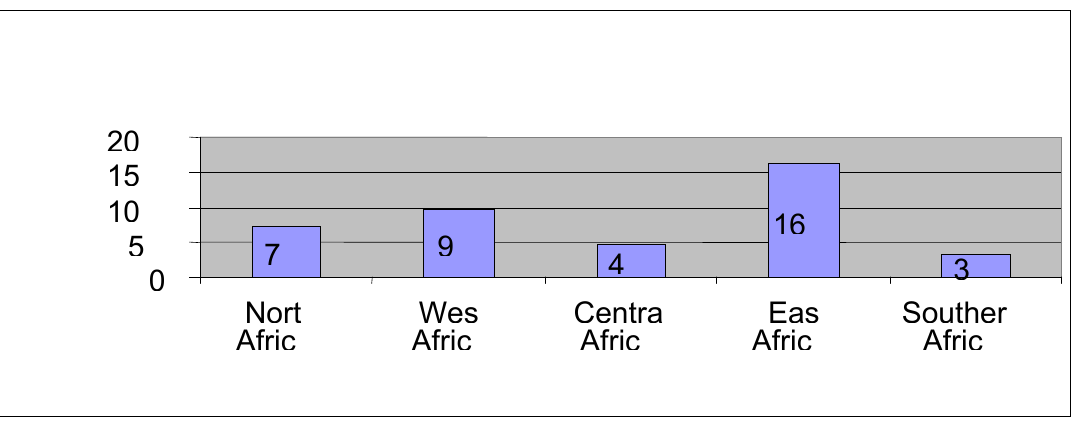
Figure 5: Flood hazards in Africa: 1974 to 2003